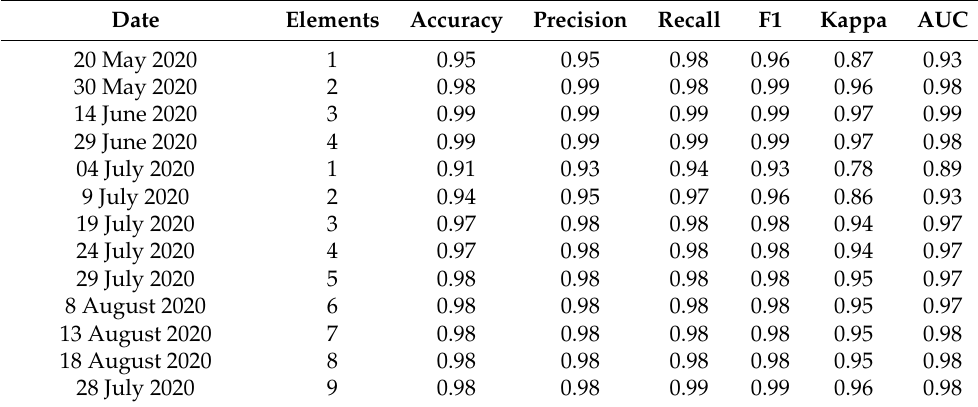
Table 6. CLAML-TS metrics values.